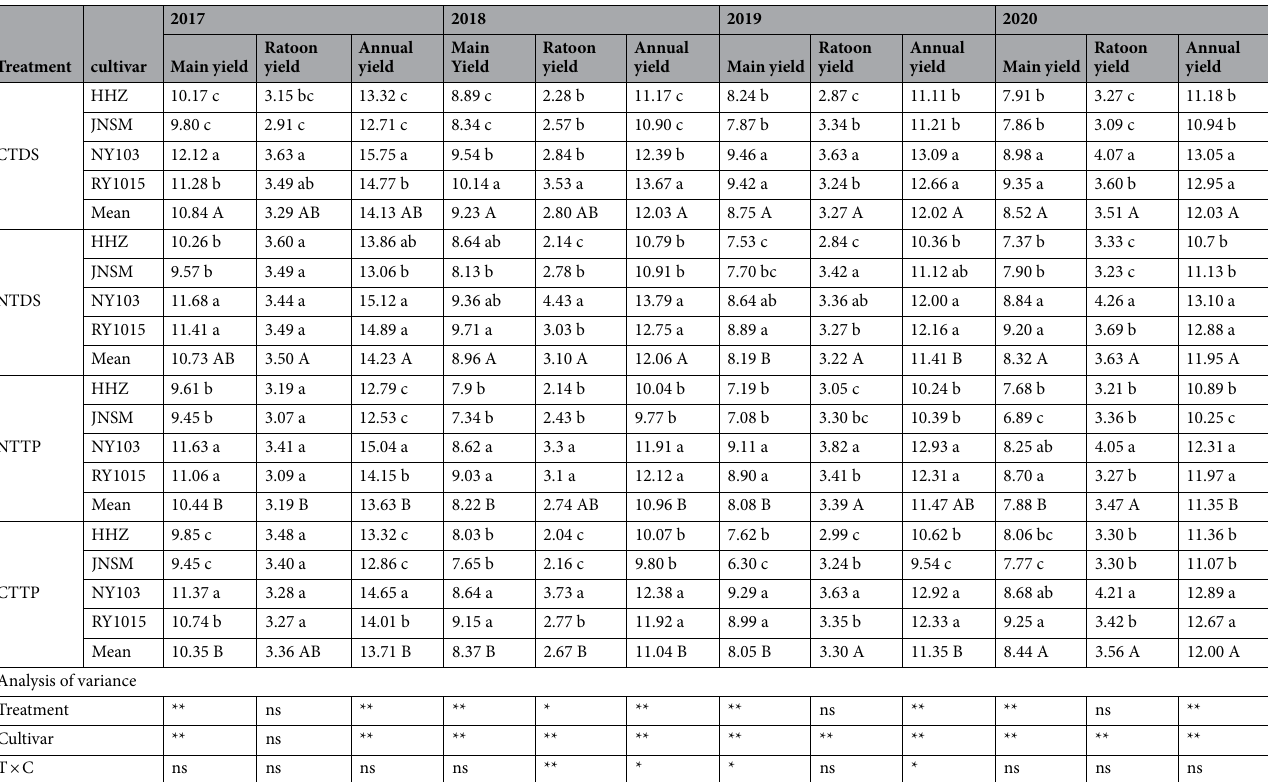
Table 3. Main season yield, ratoon season yield and annual yield of four rice cultivars grown under four cultivation methods in 2017–2020. a CTDS, NTDS, NTTP and CTTP represent conventional tillage and direct seeding, no-tillage and direct seeding, no-tillage and transplanting and conventional tillage and transplanting respectively. b HHZ, JNSM, NY103 and RY015 are Huanghuazhan, Jinnongsimiao, Nei6you103 and Rongyou1015, respectively. Within a column means followed by the same letter are not significantly different according to LSD at P = 0.05. Lower-case and upper-case letters indicate comparison among four Cultivars and between four cultivation treatments, respectively. *Significant at P < 0.05, **Significant at P < 0.01, ns, not significant at P <